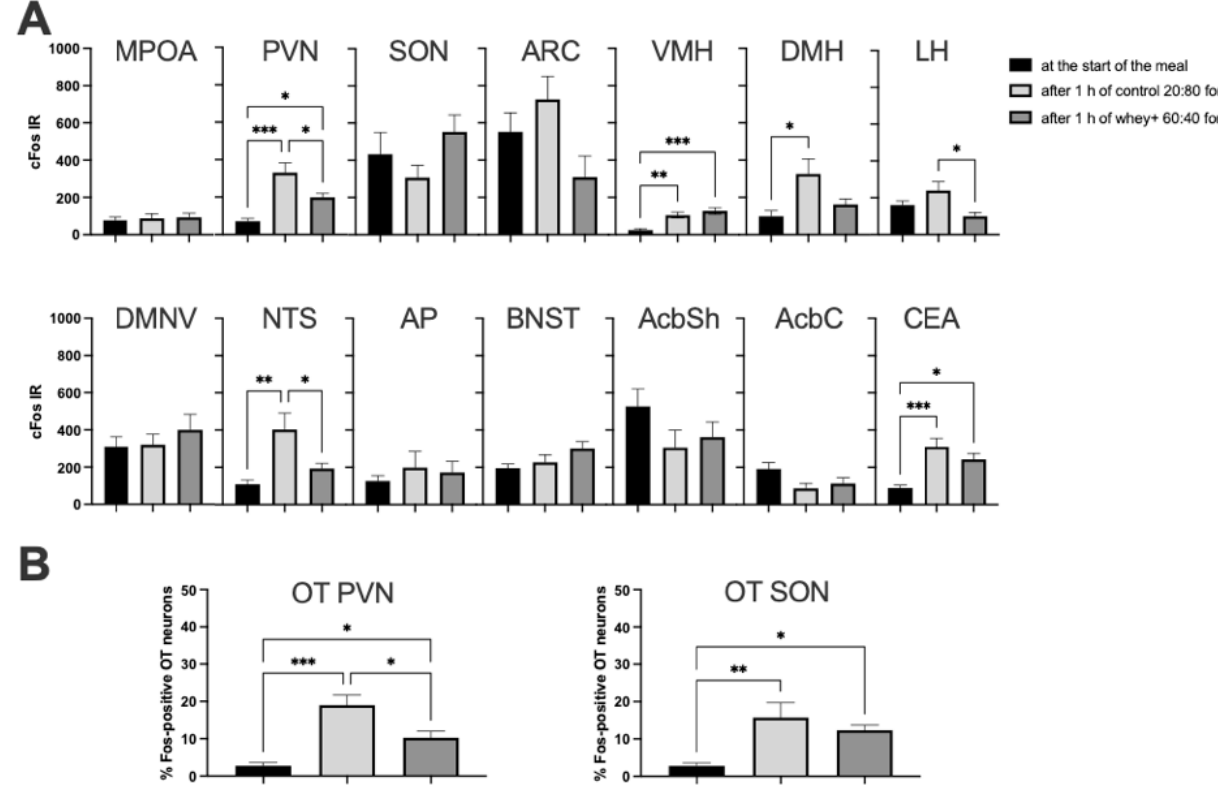
Figure 3. c-Fos immunoreactivity in feeding-related brain sites ( A ) and in OT neurons ( B ) corresponding to the start of the meal (baseline-black bars) or after 1 h of ingesting a similar amount of the Control 20:80 whey:casein CM (light grey bars) or of the 60:40 whey-casein (whey+) CM.